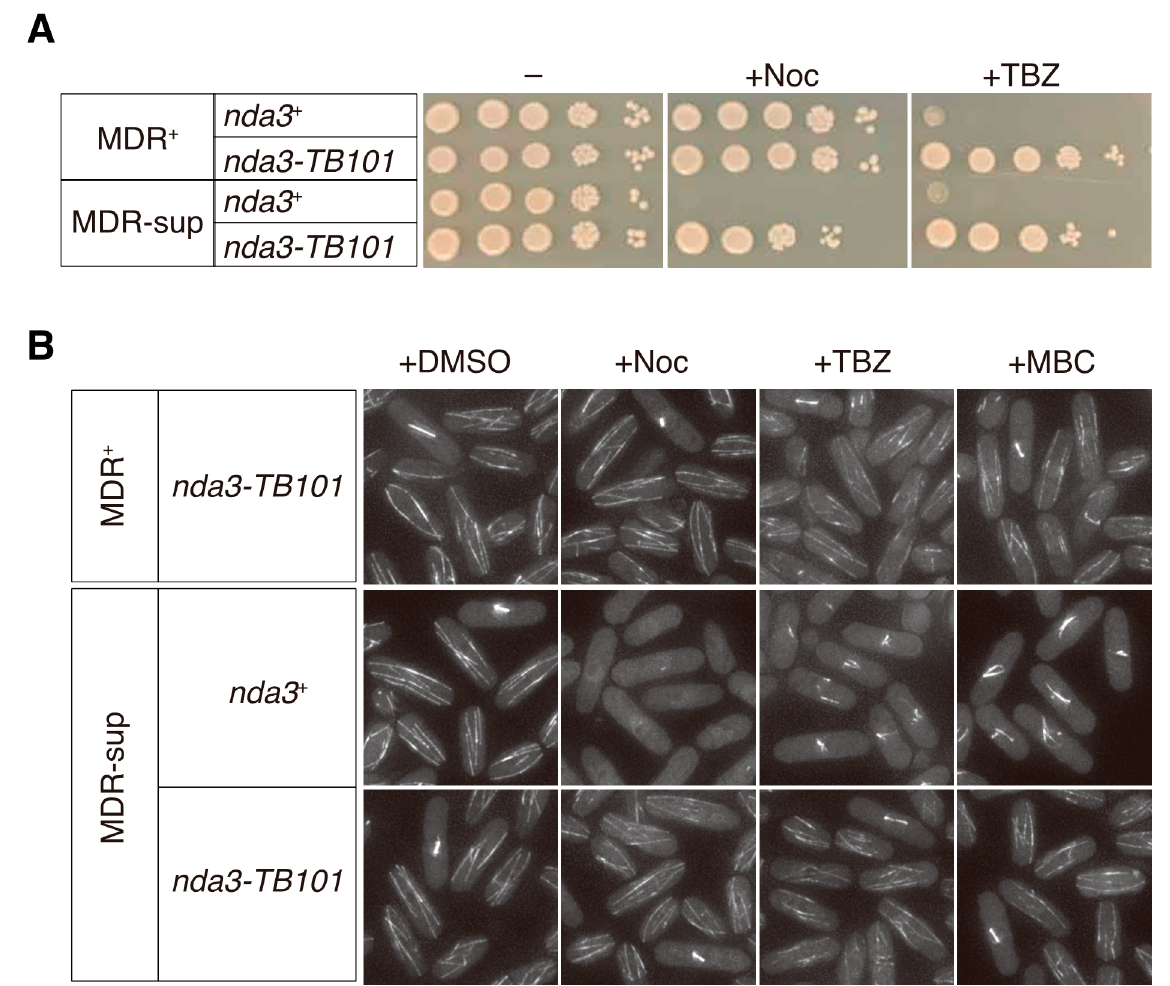
Figure 4. The nda3-TB101 mutation confers resistance to nocodazole in the drug-vulnerable strain. ( A ) The nda3-TB101 strain in the MDR-sup (multi-drug resistance suppressed) background was used to test sensitivity to nocodazole (Noc, 10 µg/mL) and TBZ (30 µg/mL). MDR + , standard genetic background. Ten-fold serial dilutions of indicated strains were spotted on rich media without (–) or with nocodazole or TBZ. The plates were incubated at 30 ℃ for 4 days. ( B ) Indicated strains expressing GFP-Atb2 were grown at 30 °C in the absence of drugs (+DMSO) as well as in the presence of nocodazole (+Noc, 10 µg/mL), TBZ (50 µg/mL), and MBC (50 µg/mL). Scale bar, 10µm.